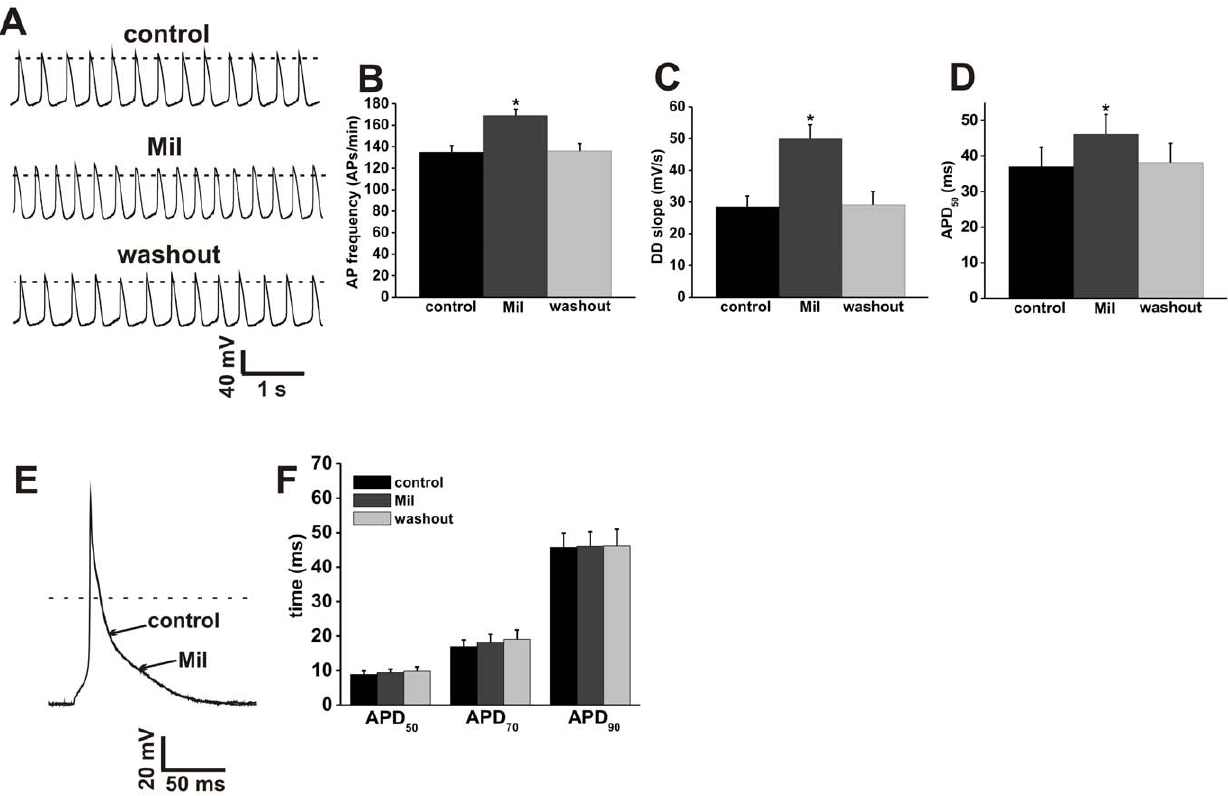
Figure 4. Effects of the PDE3 inhibitor milrinone on action potential firing in SAN and atrial myocytes. A. Representative spontaneous AP recordings (5 s duration) in control conditions, in the presence of Mil (10 m M) and after Mil washout. Dotted lines are at 0 mV. Summary bar graphs illustrate the effects of Mil on spontaneous AP frequency ( B ), DD slope ( C ) and APD 50 ( D ). E. Representative stimulated right atrial myocyte APs in control conditions, in the presence of Mil (10 m M) and after Mil washout. Dotted line is at 0 mV. F. Summary of the effects of Mil on atrial AP duration (APD 50 , APD 70 , and APD 90 ). Summary data are means 6 SEM; n =9 SAN myocytes and 9 right atrial myocytes; * P , 0.05 vs. control by one way ANOVA with Tukey’s posthoc